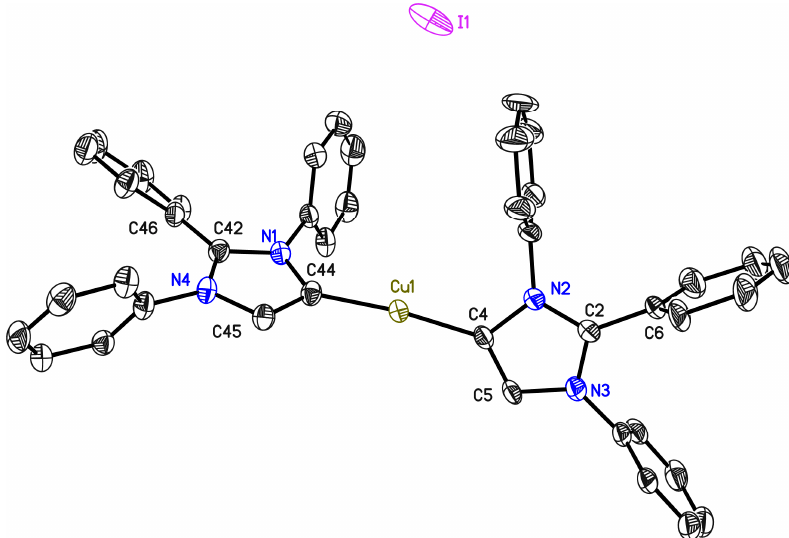
Figure 2. Molecular structure of [Cu(aIPr Ph ) 2 ]I ( 4 ). Anisotropic displacement parameters are depicted at the 50% probability level. Hydrogen atoms and isopropyl groups are omitted for clarity. Selected